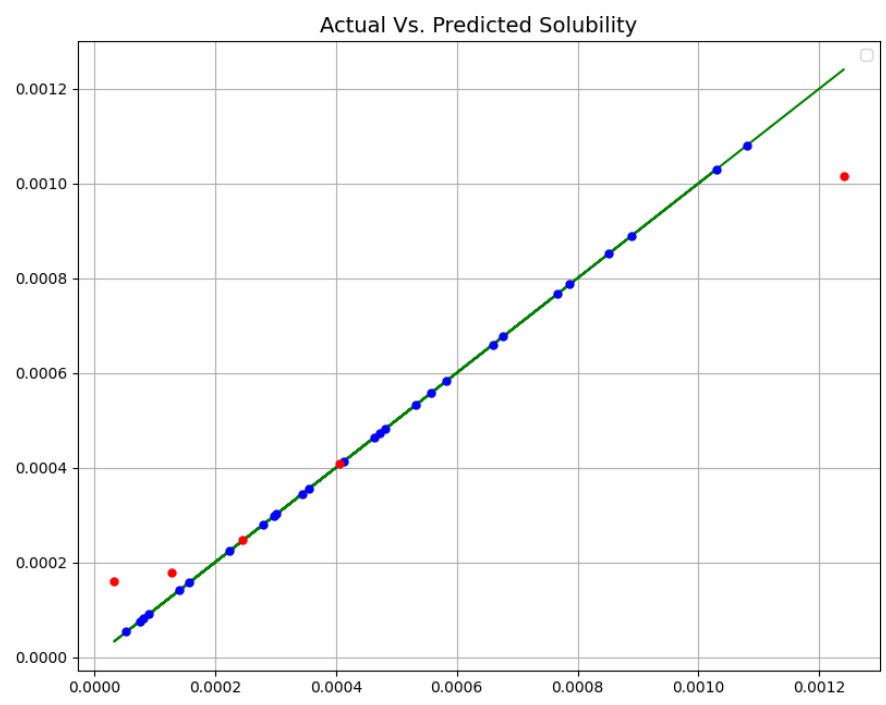
Figure 4. Real Vs. Forestalled Solubility (mole fraction) (KNN). Table 2. Outputs based on R 2 and MSE.